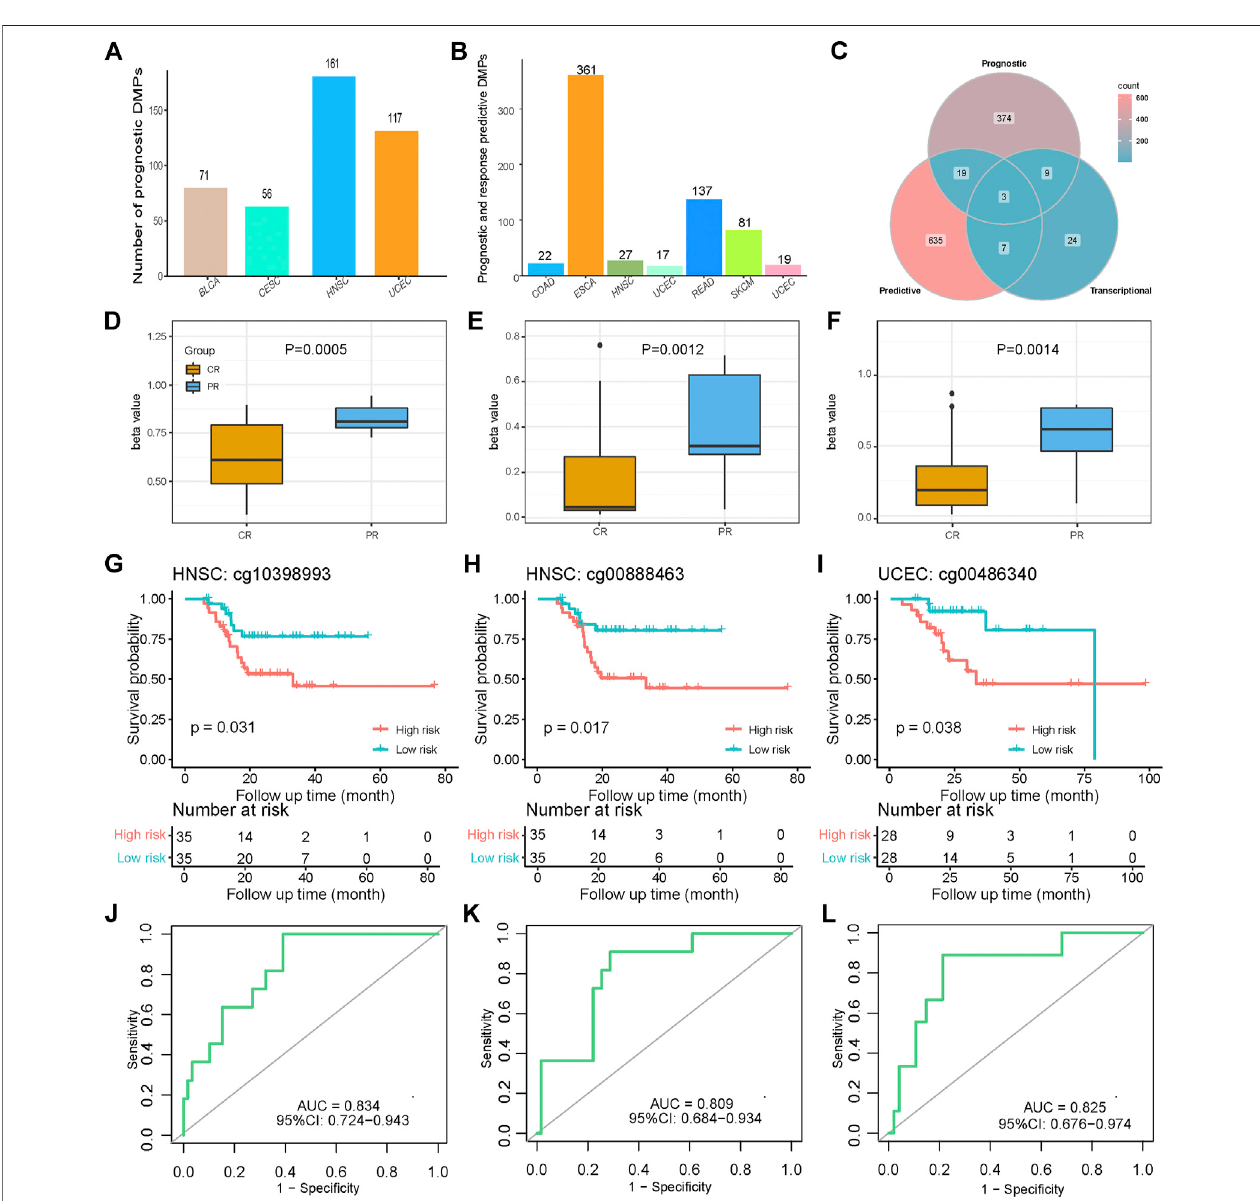
FIGURE 5 | Prognostic and platinum response-predictive DMP models. (A) Distribution of 405 prognostic DMPs among four cancer types. (B) Distribution of 664 platinum response-predictive DMPs among eight cancer types. (C) Intersection Venn plot of the prognostic, predictive, and transcriptional DMPs. (D – F) Different beta values of cg10398993, and cg00888463 in HNSC as well as cg00486340 in UCEC between the CR and PR groups. p values were calculated using the Wilcoxon test. (G – I) K-MsurvivalplotsgroupedbythebetavaluesofthethreeDMPs. p valuesweredirectlycalculatedusinglog-ranktest. (J – L) Receiveroperatorcharacteristics (ROC) curves of the three